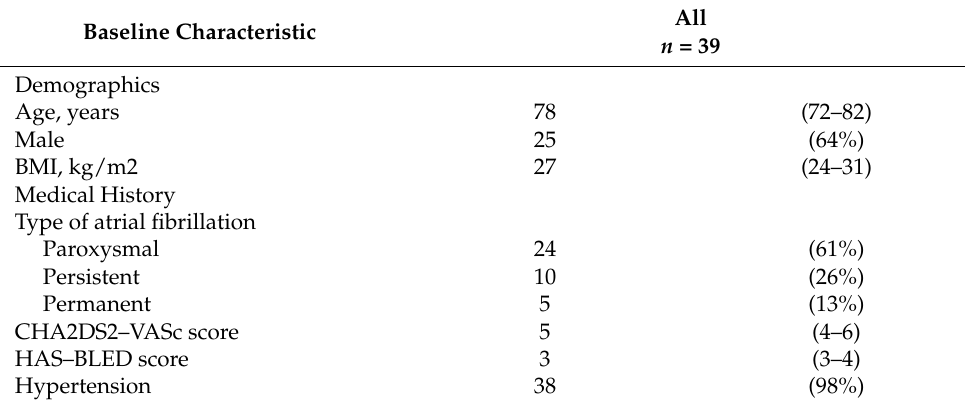
Table 1. Clinical baseline